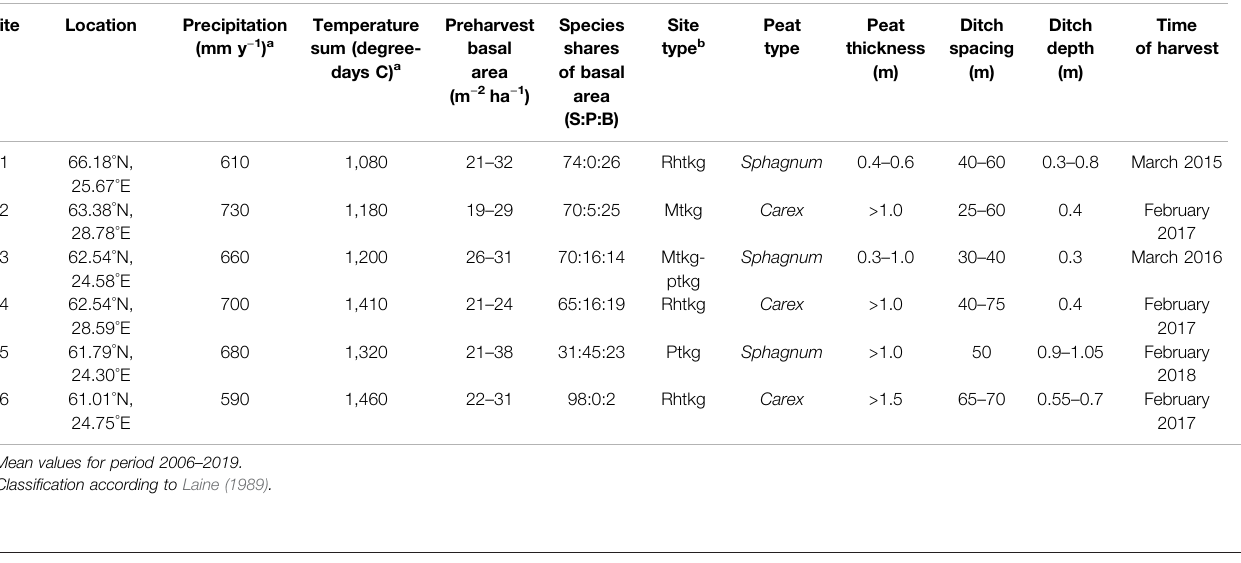
TABLE 1 | Site characteristics of the studied experimental stands on drained peatland forests in